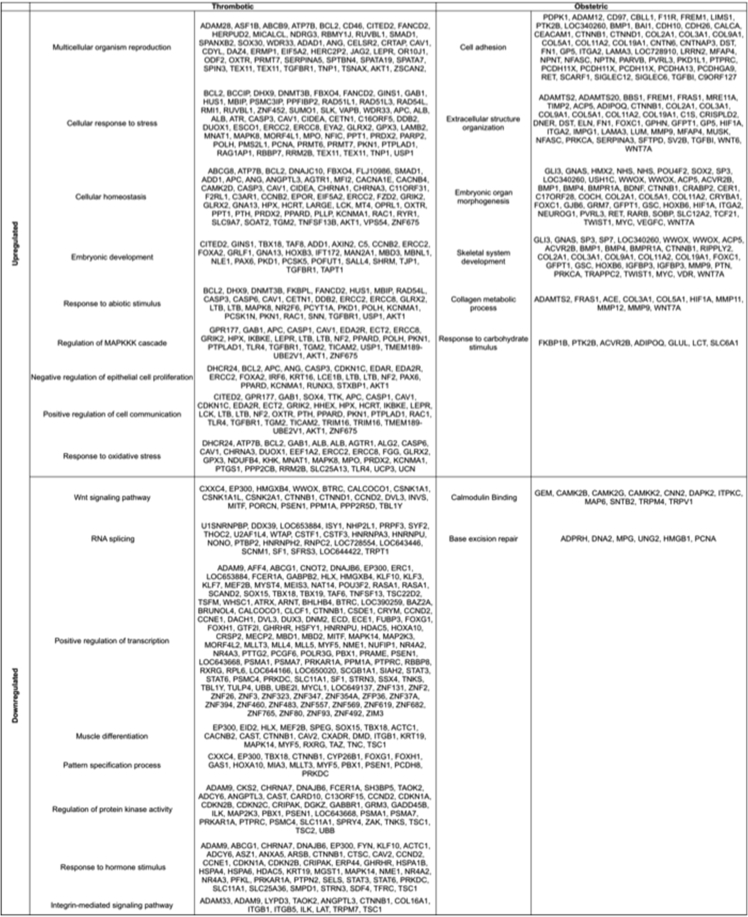
List of DE genes included in the GO in the functional categories overrepresented in monocytes exposed to VT-/PM+ and VT+/PM- IgG.